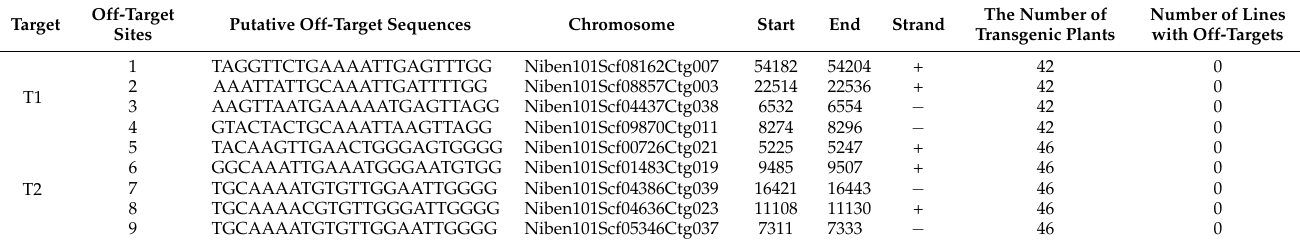
Table 2. Off-target analysis of transgenic plants transformated with PTG-ABE8e in N. benthamiana. Target Off-Target